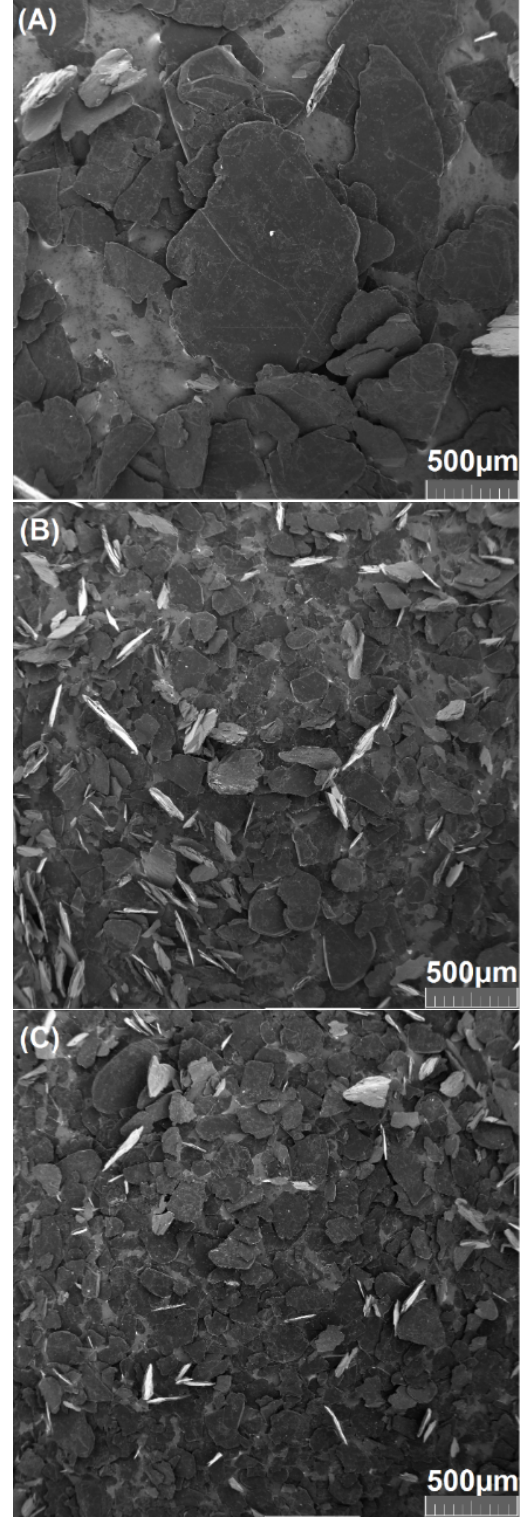
Figure 2: SEM of the NGF, (A) PS > 300 µ m, (B) 250 µ m > PS > 106 µ m, (C) 150 µ m > PS > 45 µ